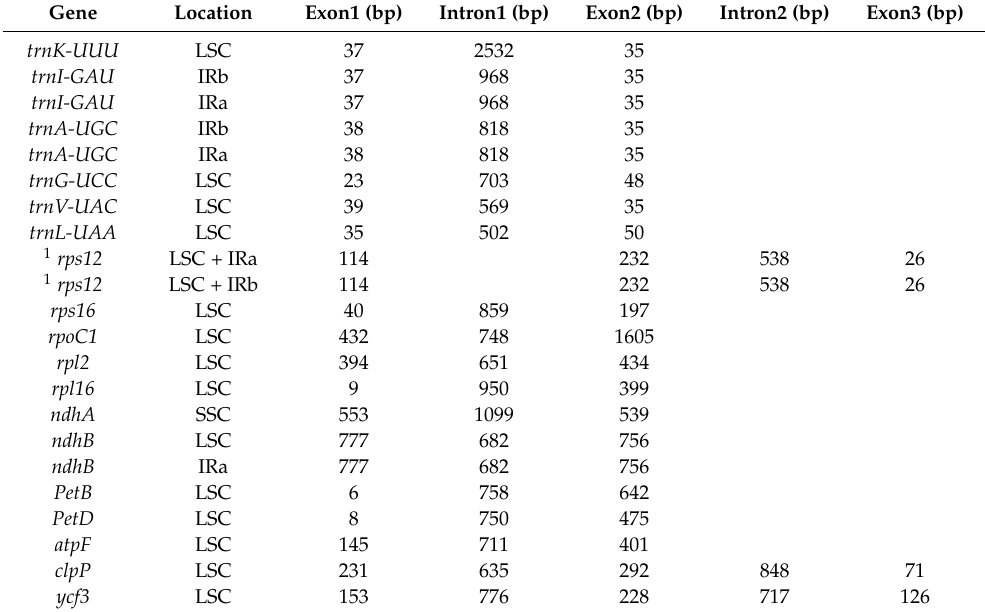
Table 2. The genes with introns in the wild S. divaricata chloroplast genome and the length of the exons and